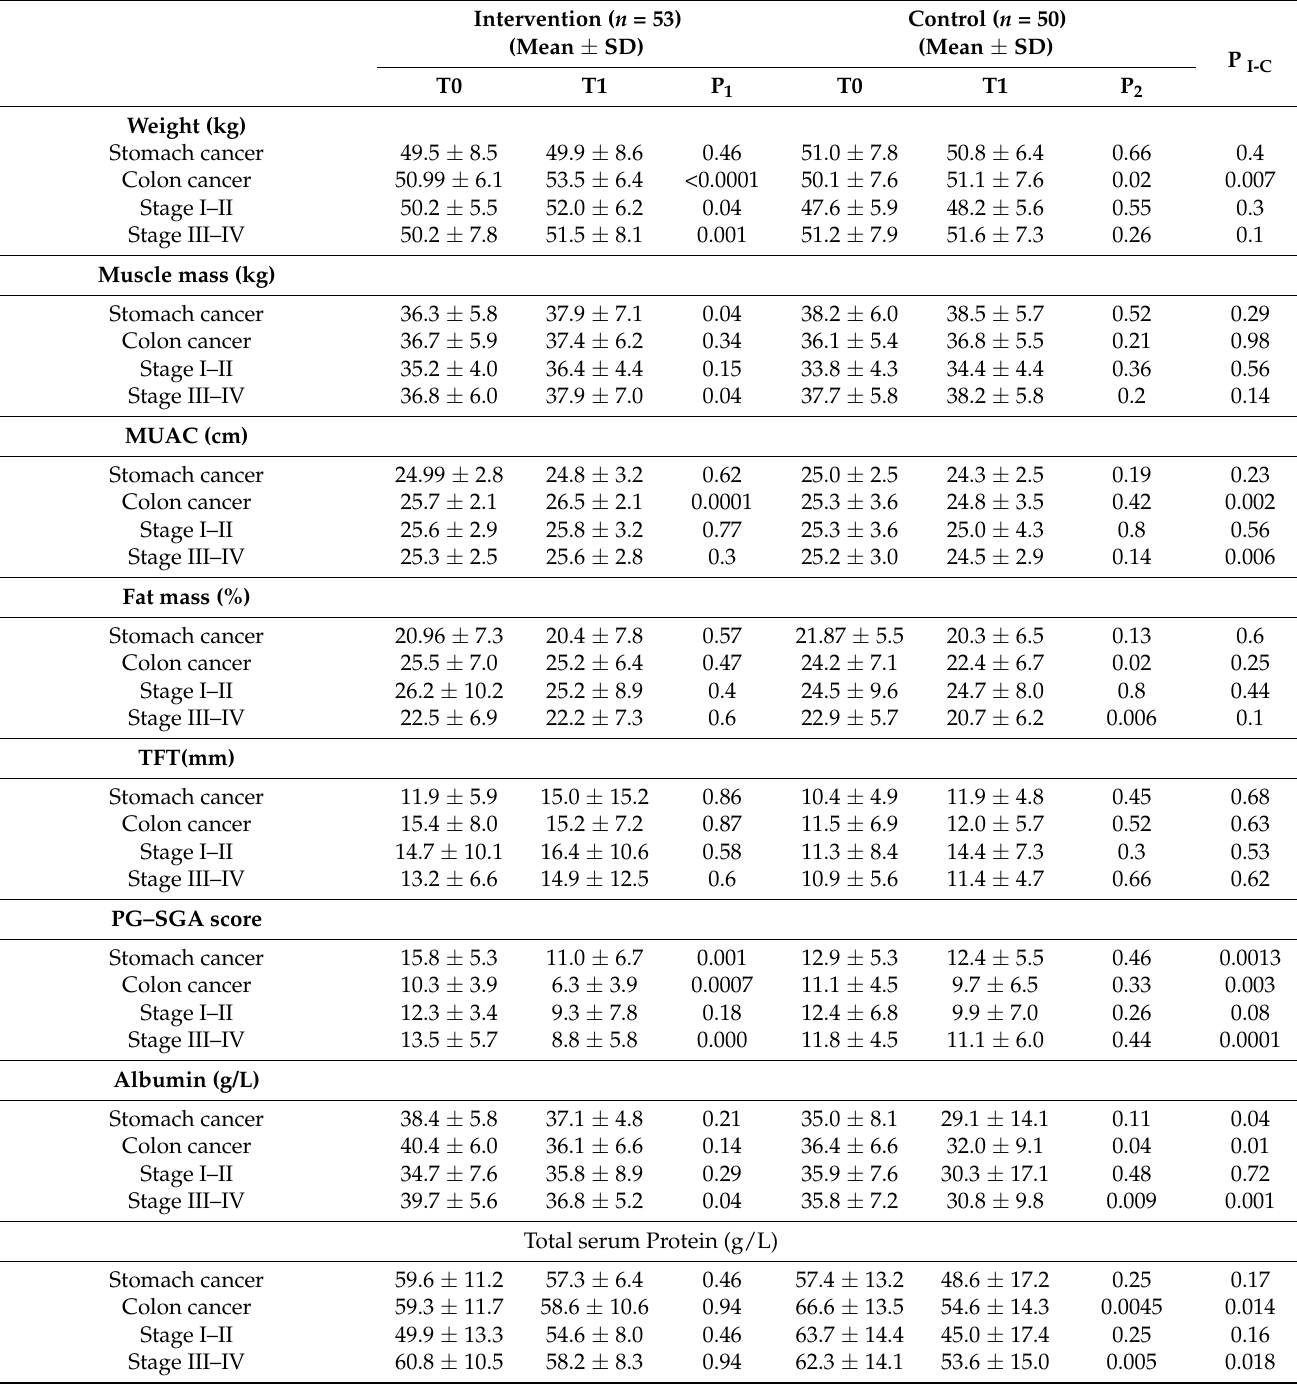
Table 3. Changes in body index and nutritional status by type of cancers and